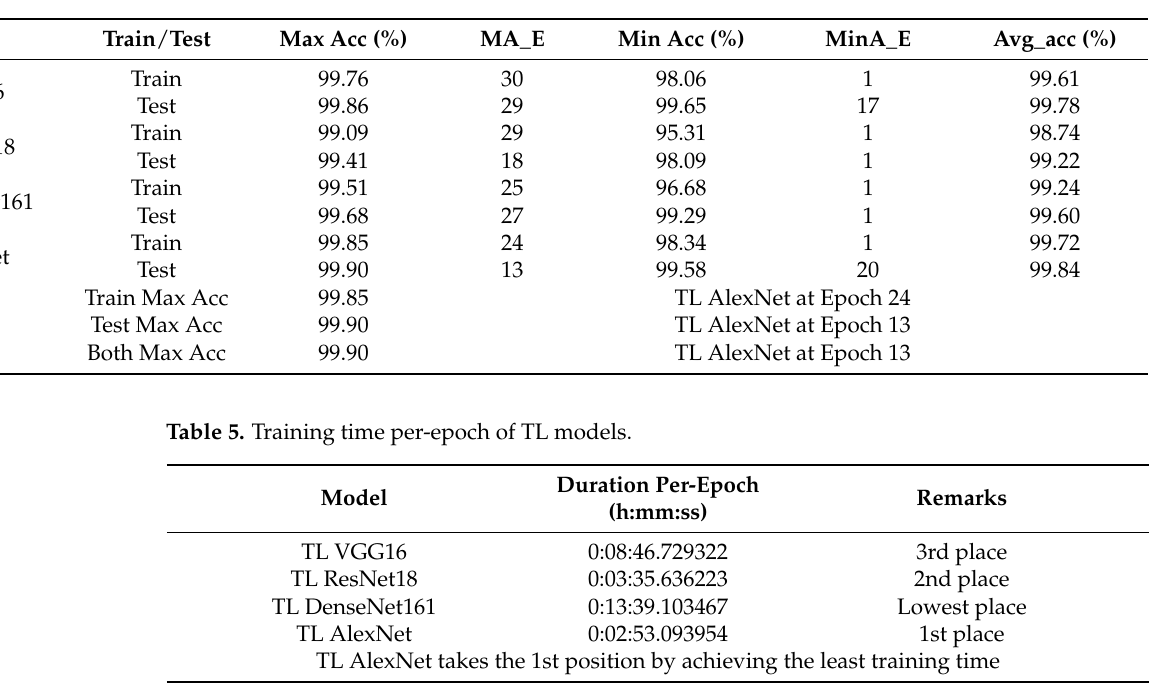
Table 4. Performance measurement of used TL methods during 30 epochs of training where MA_E = Maximum Accuracy at epoch, MinA_E = Minimum Accuracy at epoch, Avg_acc = Av- erage Accuracy.